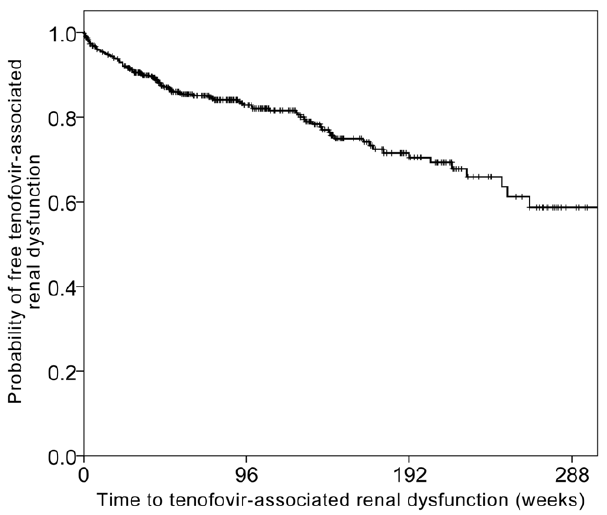
Figure 2. Kaplan-Meier curve showing the time to 25% reduction in eGFR for the whole cohort. eGFR: estimated